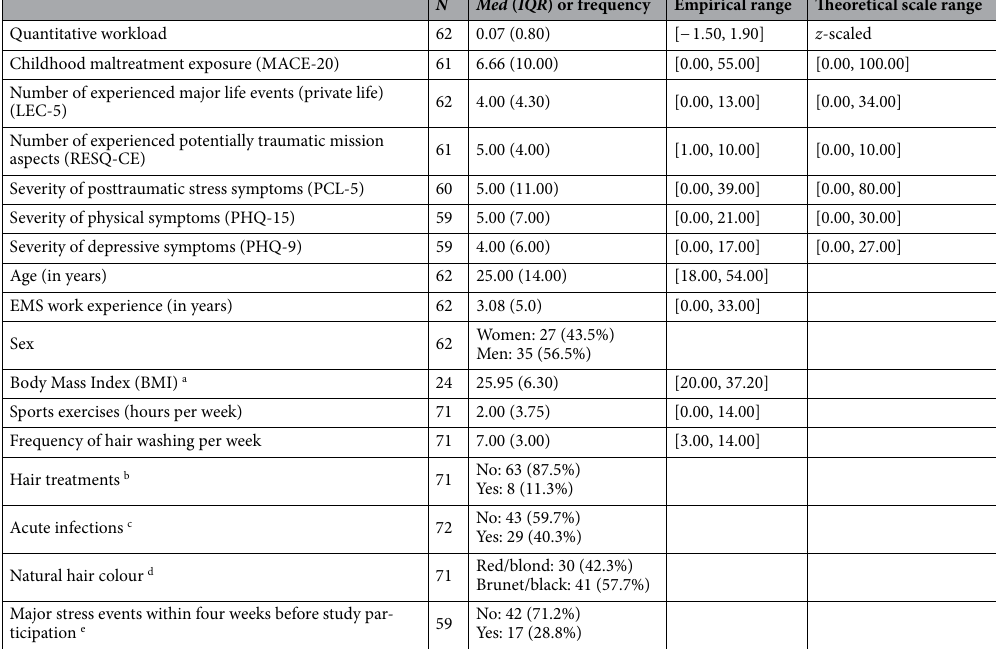
Table 1. Sample characteristics. Med median, IQR interquartile range. a BMI was introduced to the hair sample collection were considered as hair treatment. c Self-reported common colds, flu, influenza, angina, and cystitis at the time of hair sample collection or within four weeks before. d Only a small percentage of participants had red ( n = 2) or black ( n = 3) as natural hair colour. Participants with grey hair were categorised according to their initial natural hair colour. e See Supplementary Table S5 for further